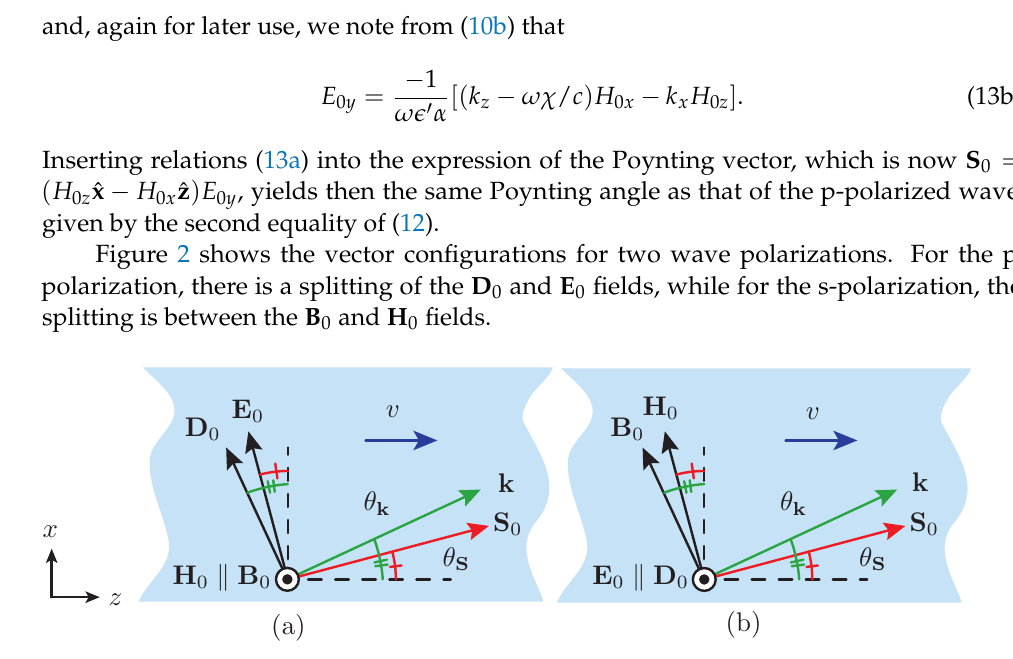
Figure 2. Electromagnetic vector configurations in the moving medium. ( a ) p-polarization; ( b )